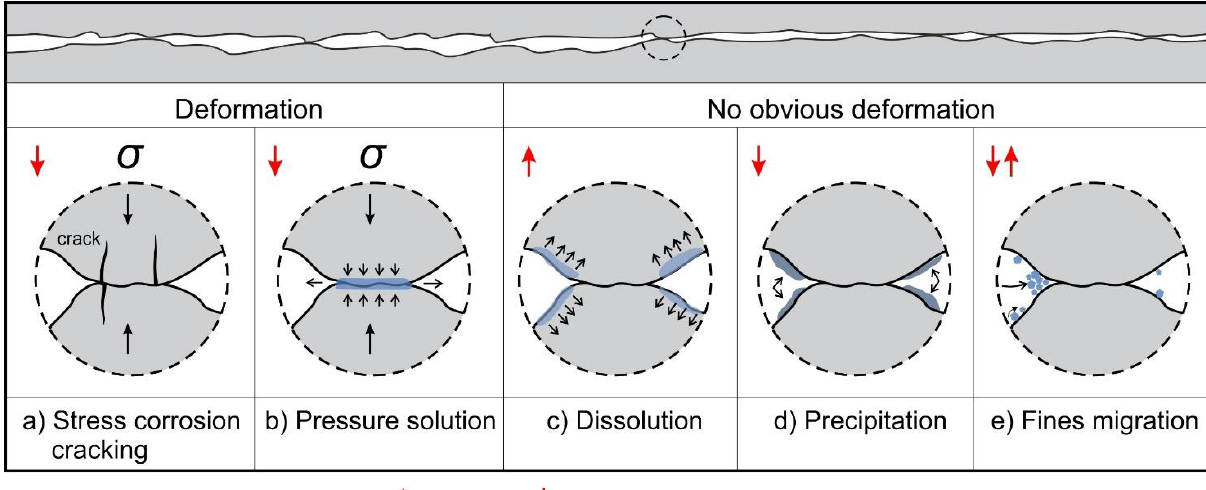
Figure 13. Potential fluid–rock interactions occurring during the long-term experiments and their effects on fracture permeability and fracture deformation. Both ( b , c ) involve dissolution of solid matter into a fluid phase, where the former is taking place within the contact area of stressed asperities and the latter occurs on the free faces of the mineral grains. ( a ) Stress corrosion cracking; ( b ) Pressure solution; ( c ) Dissolution; ( d ) Precipitaion; ( e ) Fines migration.